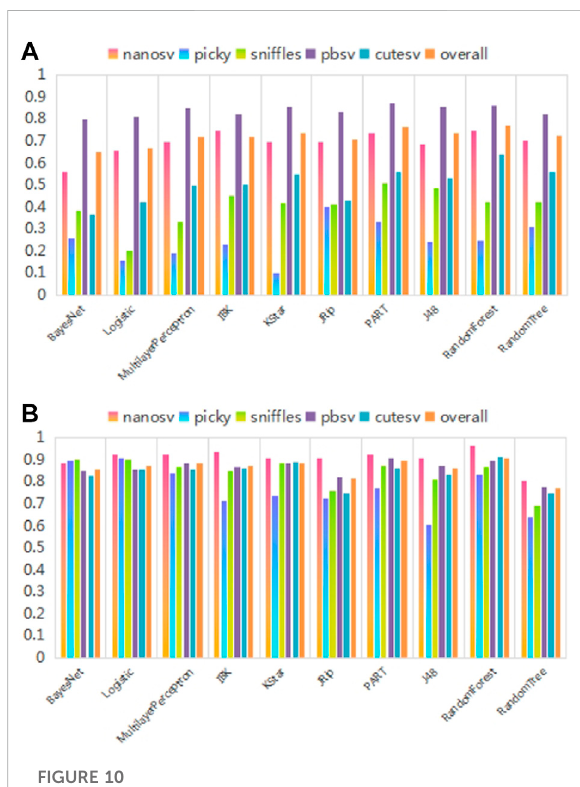
FIGURE 10 Recommendation performance of recommendation models constructed by different classi fi cation algorithms. (A) and (B) show the comparison results of different classi fi cation algorithms on f-measure and AUC performance evaluation metrics, respectively. The abscissa represents ten commonly used multi- classi fi cation algorithms based on different principles. The different colored bars for each multi-classi fi cation algorithm indicate their recommendation performance for each SV caller and overall. The ordinate is the performance evaluation metric